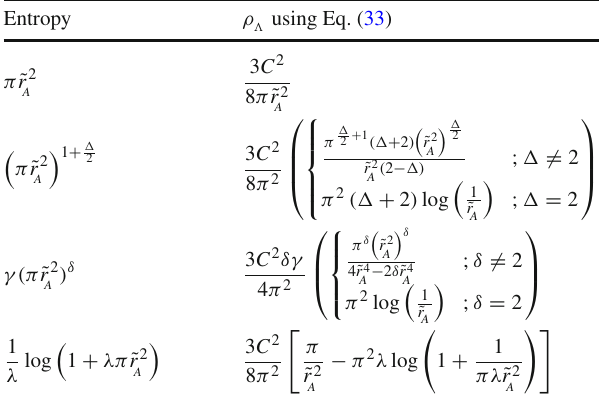
Table 2 Different entropies and corresponding dark energy densities using the Eq. (33) Entropy ρ (cid:2) using Eq.